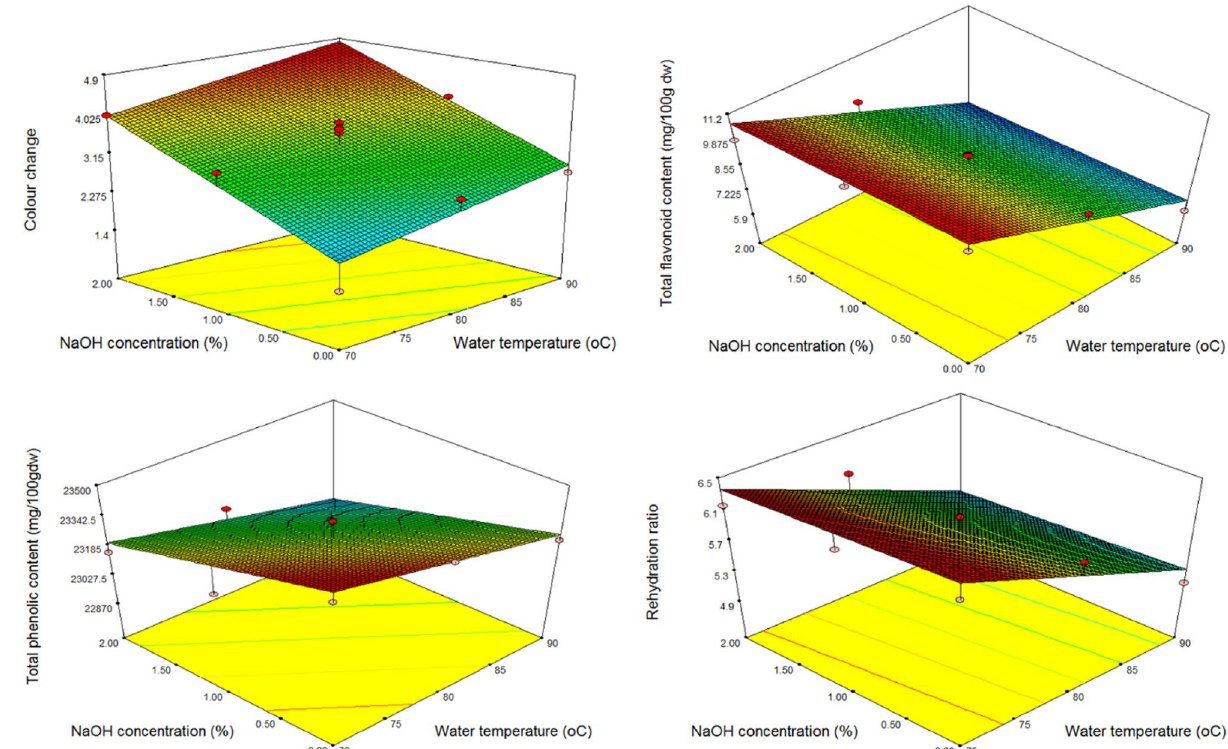
Figure 1. Effect of water temperature and NaOH concentration on quality parameters of dried black